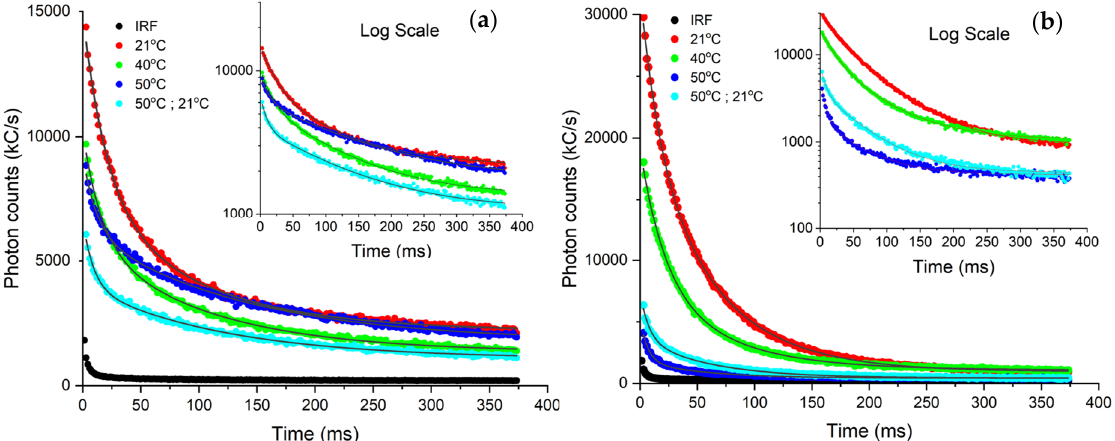
Figure 7. Photon lifetime curves acquired from our York DF Photon Counting Device for heat stressed: ( a ) Prunus virginiana and ( b ) Coleus amboinicus. The plants were subjected to temperatures 21 ◦ C (red), 40 ◦ C (green), 50 ◦ C (blue), 50 ◦ C returned to ambient (cyan). Black line indicates the instrument response function. Table 1. Lifetime values of heat stressed Prunus virginiana and Coleus amboinicus .